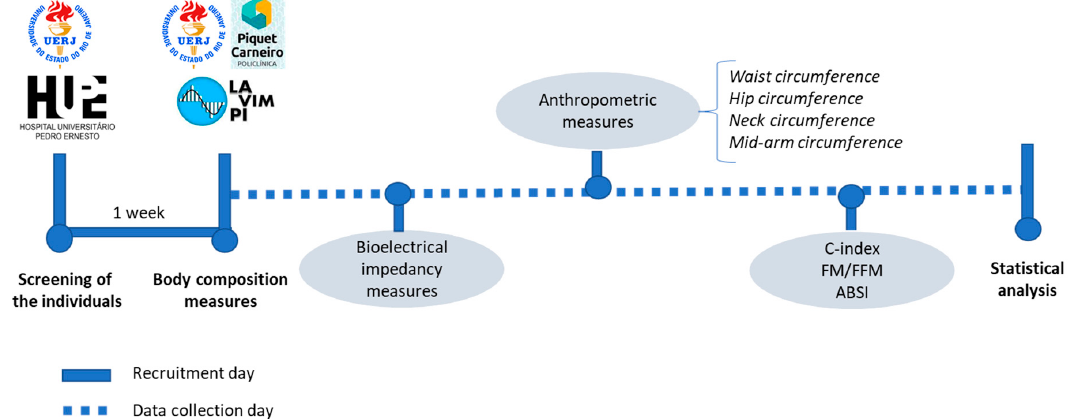
Figure 1. Timeline of the steps of the study. C-index—Onicity index; FM/FFM—Fat mass/fat free mass; ABSI—A body shape index.